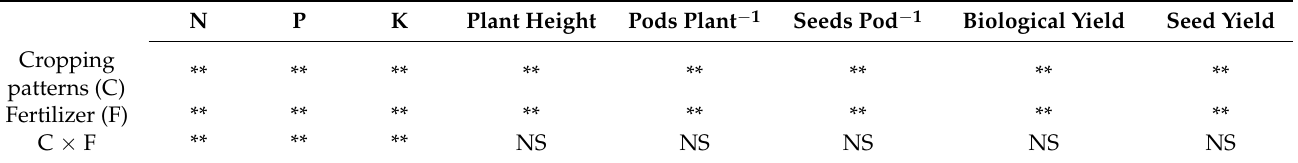
Table 4. The analysis variance of mung bean traits under experimental factors.